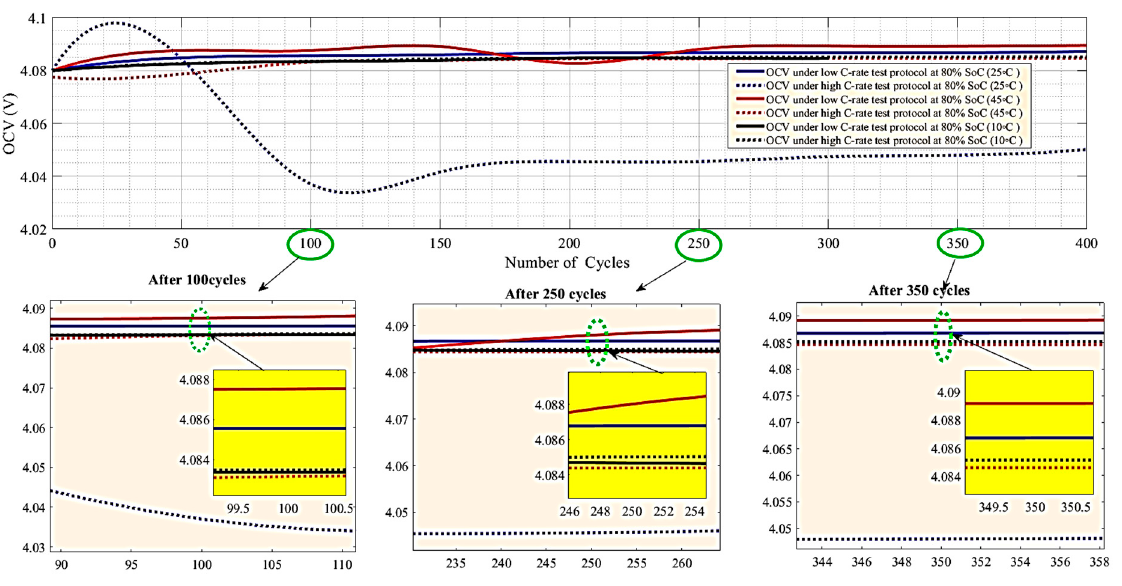
Figure 15. Behavior of OCV at 10 °C, 25 °C, and 45 °C under high and low discharge tests during the lifetime of the battery at 80% SoC.